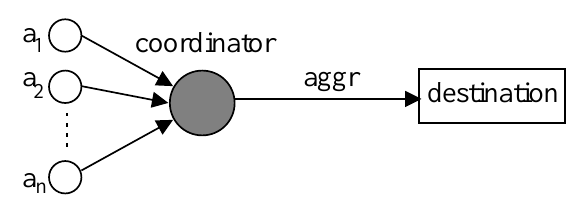
Figure 1. Multi-Origin